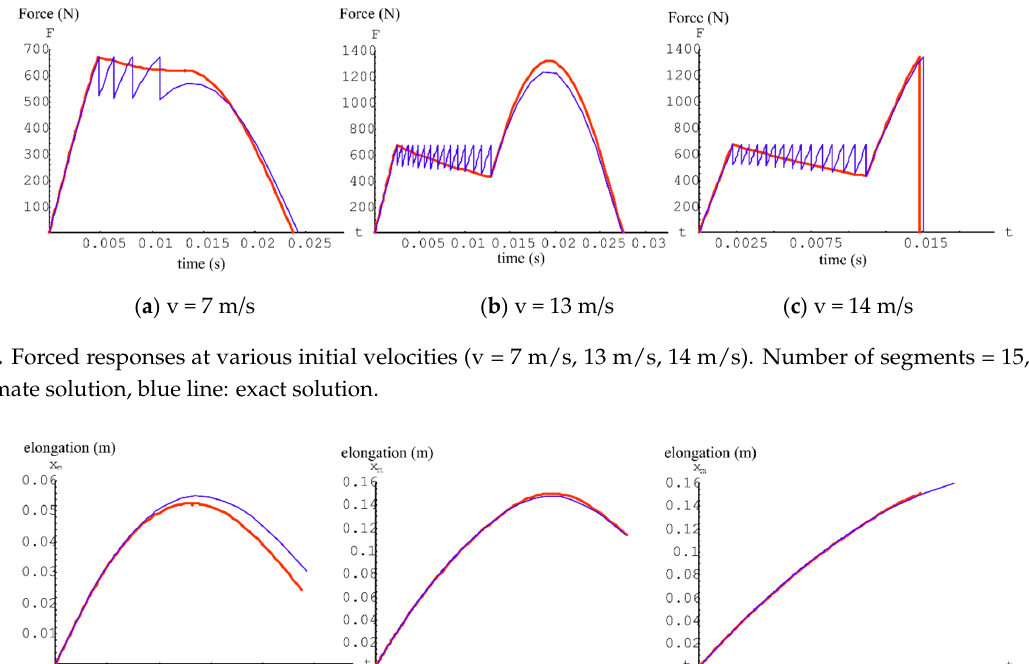
( c ) v = 37 m/s Figure 9. Forced responses at various initial velocities (v = 20 m/s, 34 m/s, 37 m/s). Number of seg- ments = 100, red line: approximate solution, blue line: exact solution.